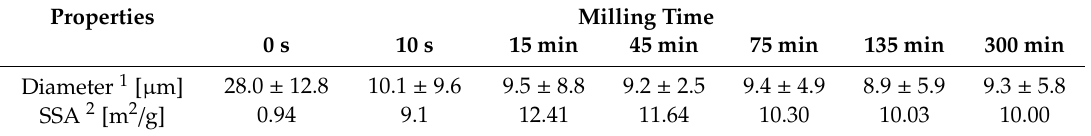
Table 1. Morphological properties of the MgH 2 powder before and after milling for various times. Properties Milling